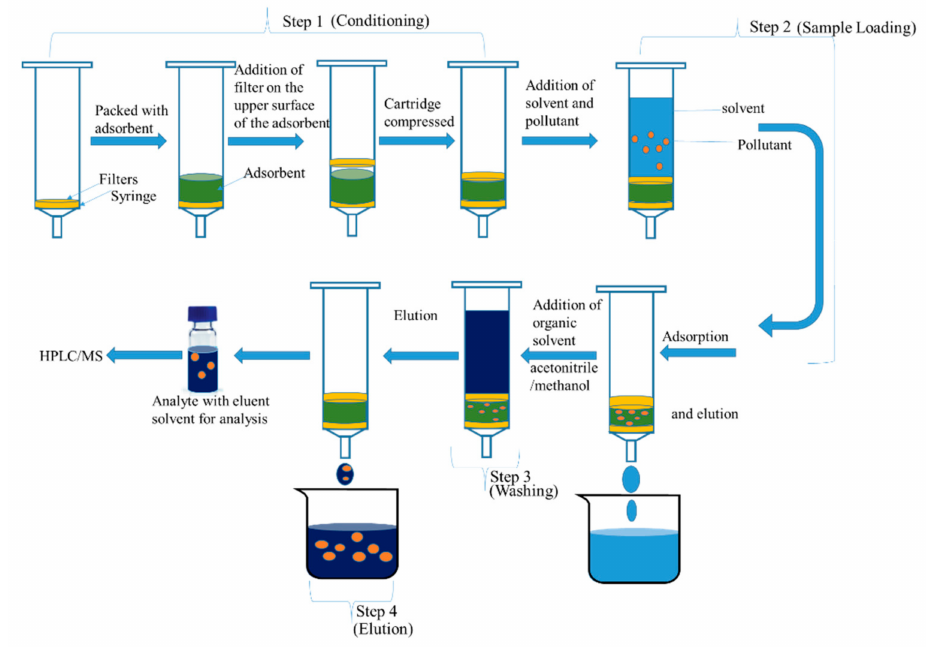
Figure 2. Diagrammatic steps of solid phase extraction (adapted from Badawy et al.